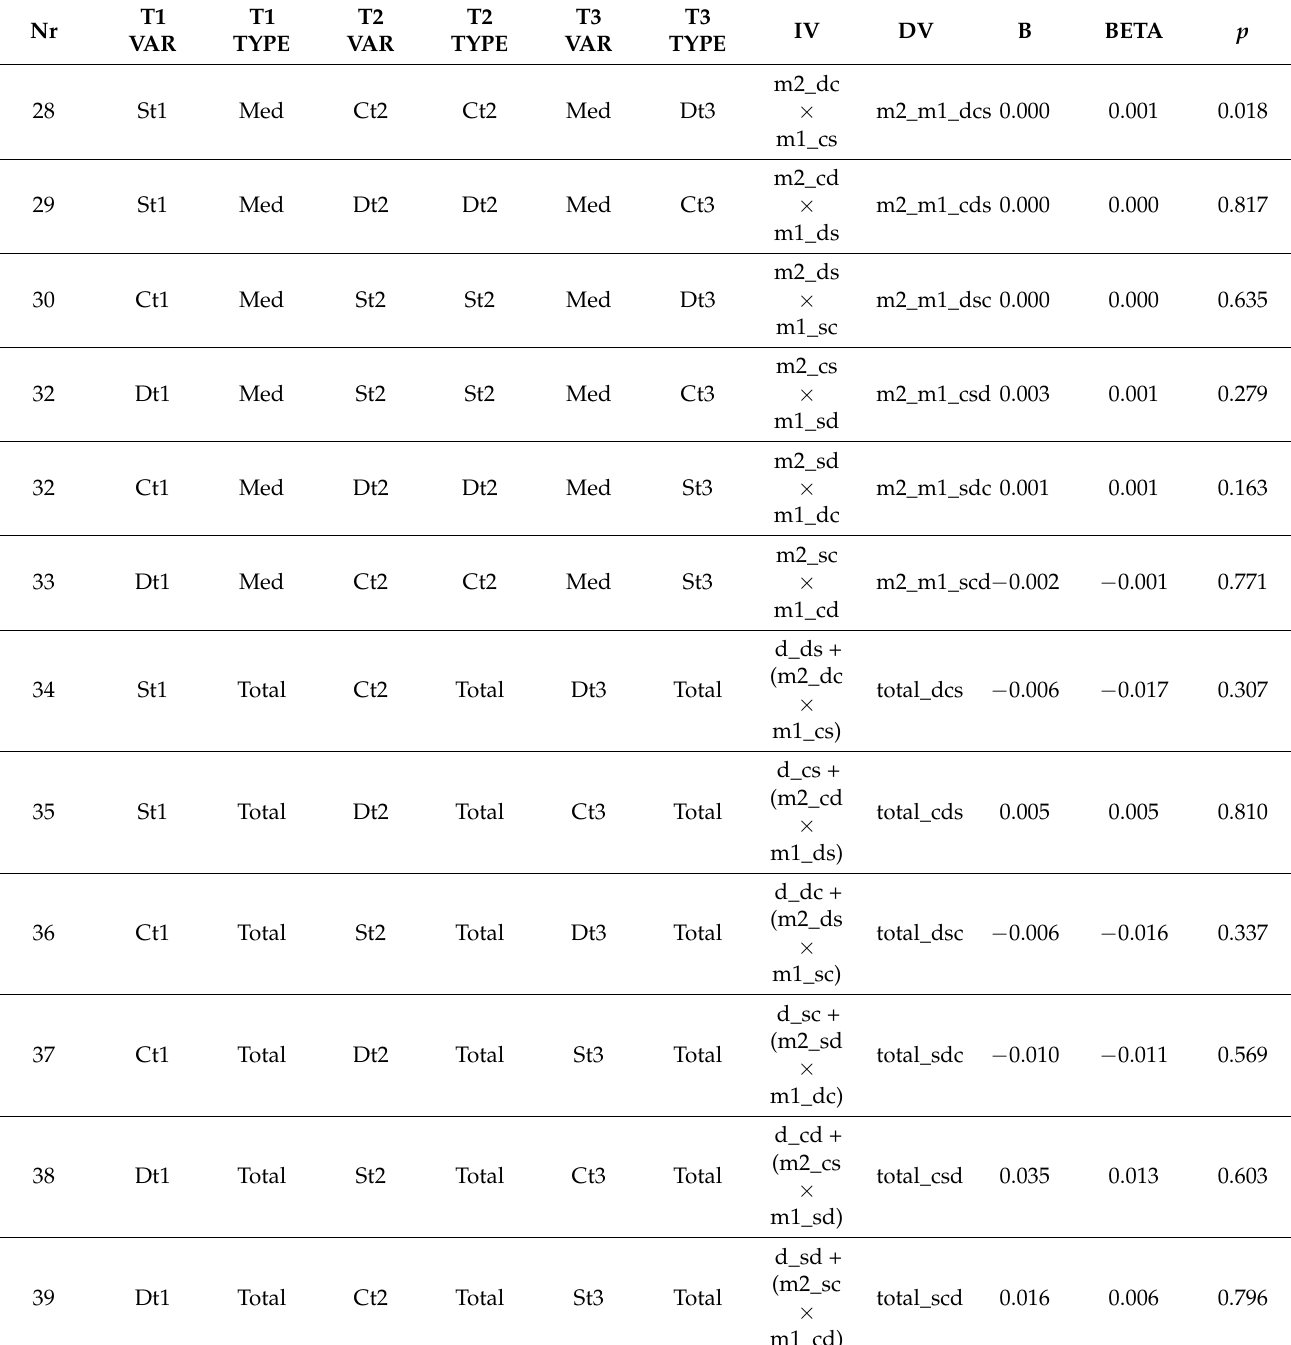
Table A4. Model estimates from the structural regression (pathway) analysis: mediation effects (“Med”) and total effects (“Total”) estimates. Rows 28 and 32 are the relevant indirect effects; rows 34 and 39 are the relevant total effects. The core results from this study are found in row 28, which shows that screen time at T1 indirectly predicts depressive symptoms at